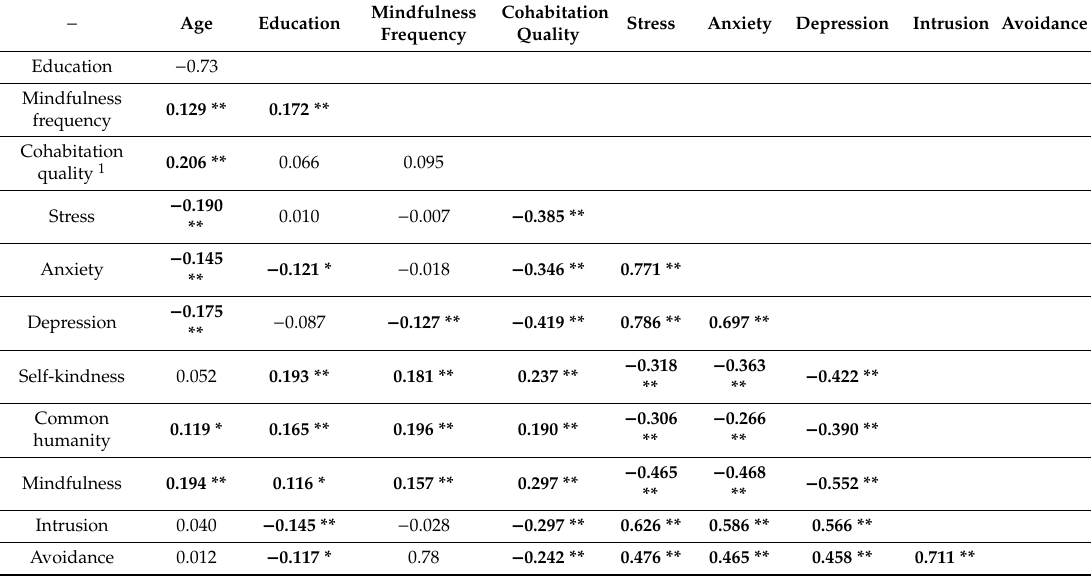
Table 3. Correlation coe ffi cients between sociodemographic variables and the subscales evaluated. − Age